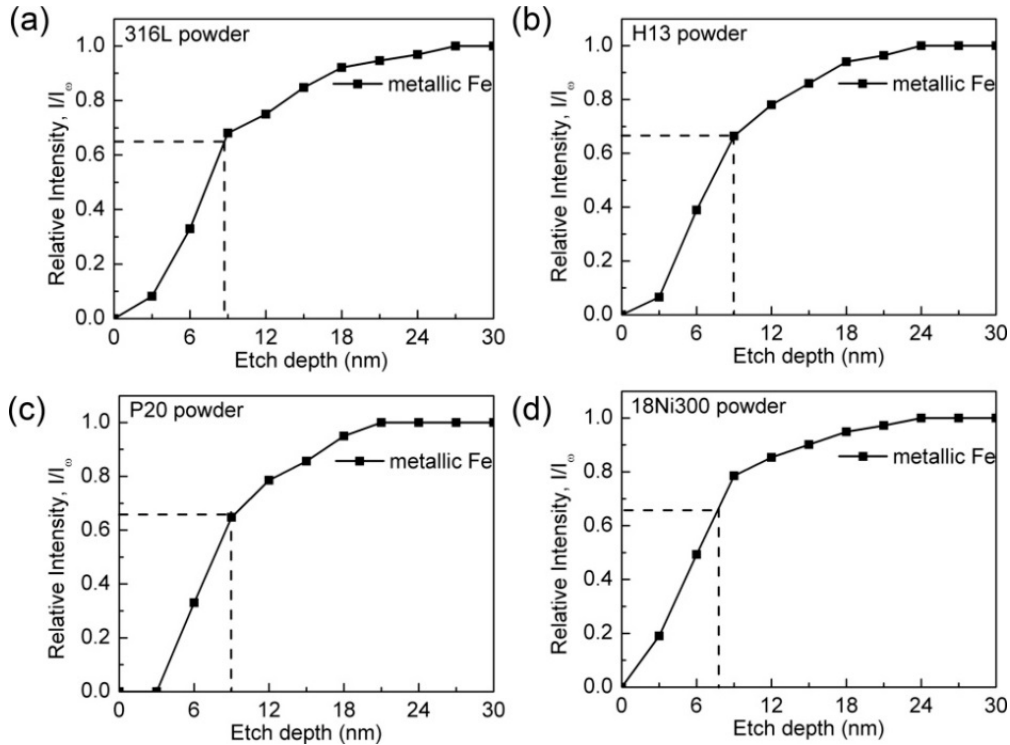
Figure 7. Estimation for the thickness of the iron oxide layer by the normalized intensity of metallic Fe peak for ( a ) 316L, ( b ) H13, ( c ) P20 and ( d ) 18Ni300 powders.